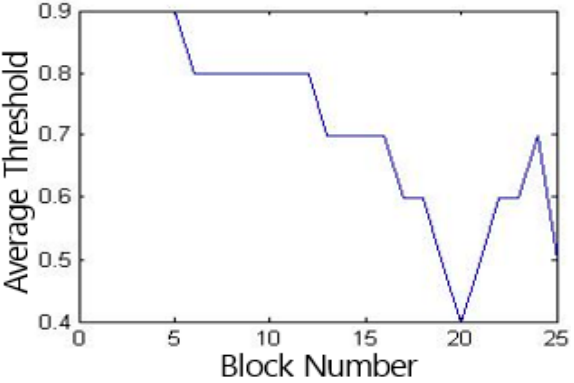
Figure 10. Average threshold distribution of average entropy matrix.